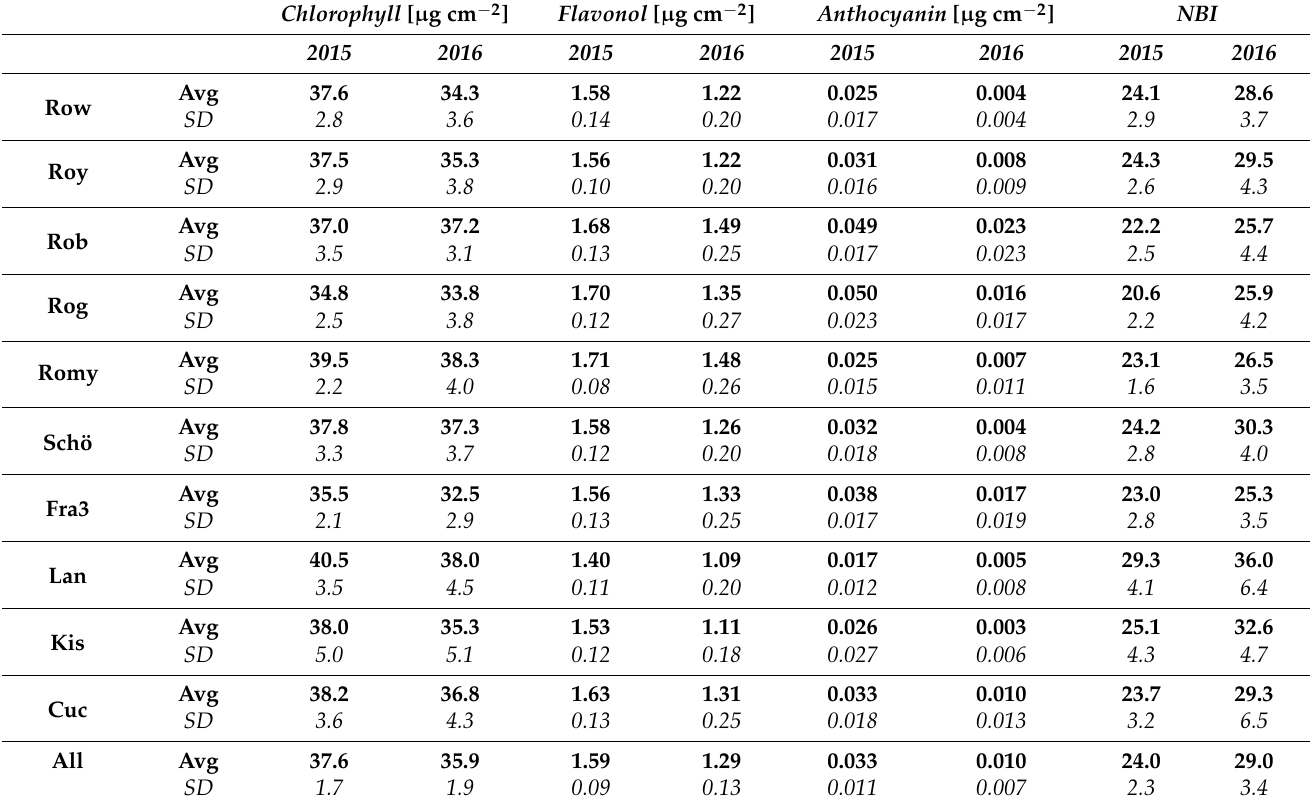
Table 5. Mean values of Dualex ® parameter determined on Robinia leaves of different clones and provenances at clonal test plot Welzow in 2015 and